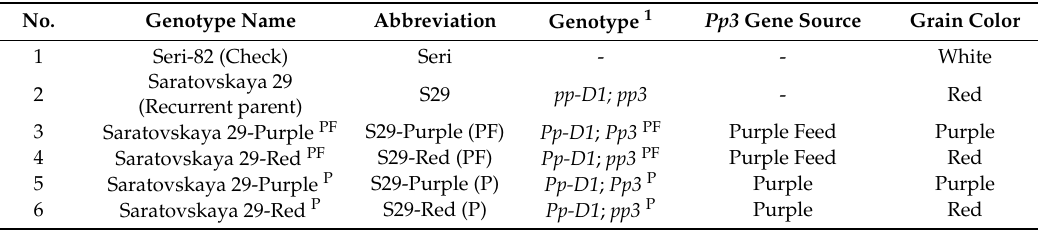
Table 1. Description of the material used in the